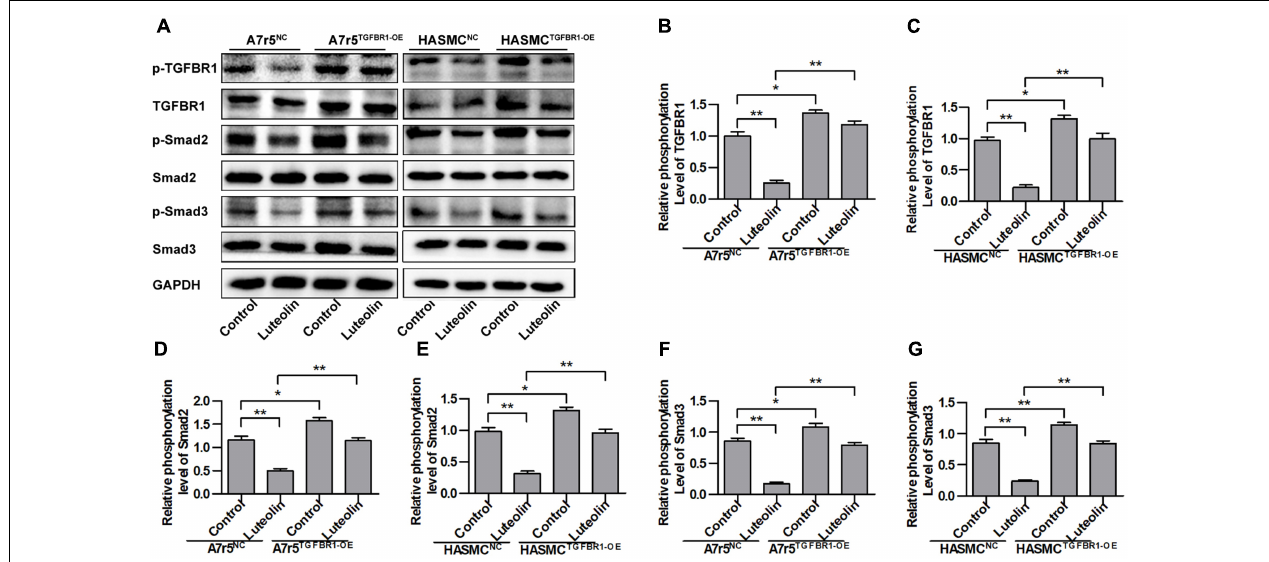
FIGURE 4 | Overexpression of TGFBR1 partially rescues TGFBR1 activation after luteolin treatment. (A) A7r5 and HASMC cells, respectively, were incubated with a TGFBR1 overexpression adenovirus vector and GFP control adenovirus for 48 h. Cells were then treated with luteolin (40 µ M) for 1 h. The expression levels of p-TGFBR1, TGFBR1, p-Smad2, Smad2, p-Smad3, and Smad3 were tested by western blotting. (B – G) Relative phosphorylation levels of TGFBR1, Smad2, and Smad3 ( n = 3). Data are presented as the mean ± SD. ∗ P < 0.05, ∗∗ P < 0.01, compared to the control